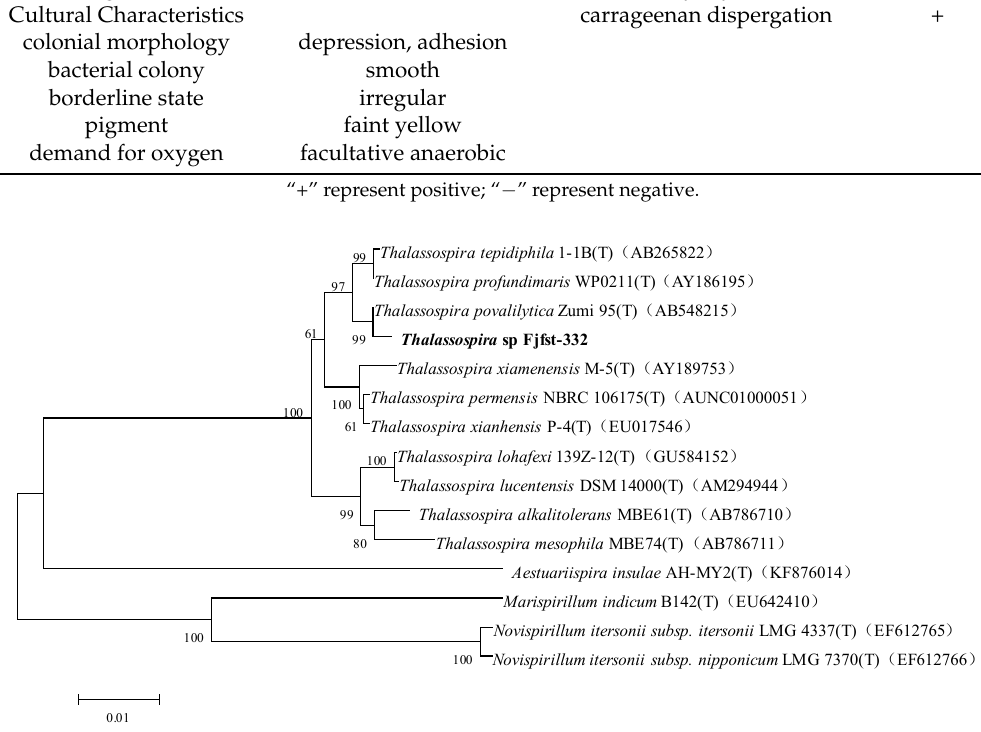
Figure 2. Phylogenetic tree of Thalassospira sp. Fjfst-332 based on 16S rDNA sequences and Neighbor Joining analysis.